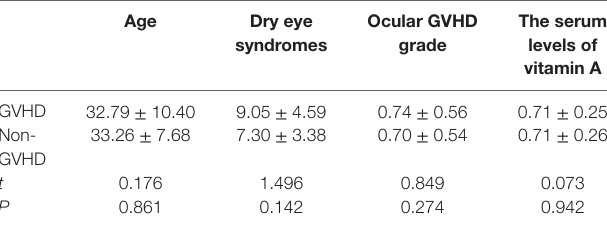
Table 3 | Ocular graft-versus-host disease (gVhD) severity and serum vitamin a levels in patients with or without systemic gVhD.